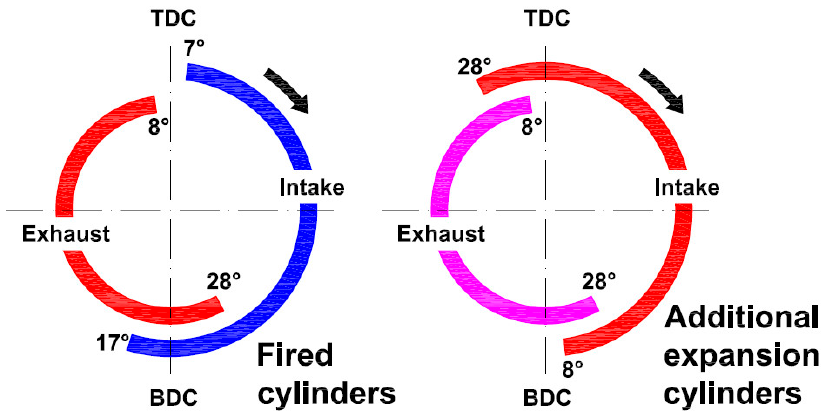
Figure 4. Valve timing of the test engine; Top Dead Center (TDC).